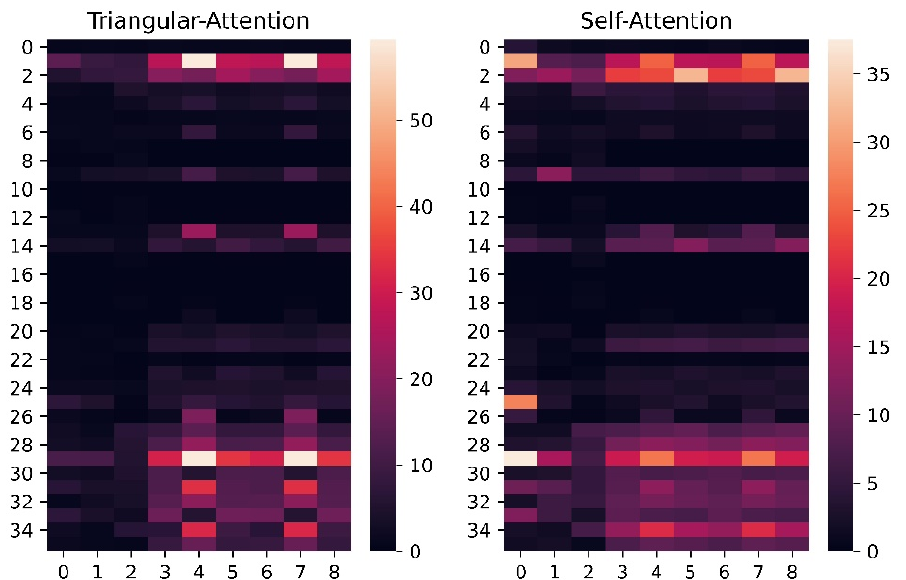
Figure 12. Visualization of weighting score calculated by the triangular attention and the self- attention. The three samples numbered 0 to 2 represent Vundo in Dataset A, and the three samples numbered 3 to 5 represent Tracur in Dataset